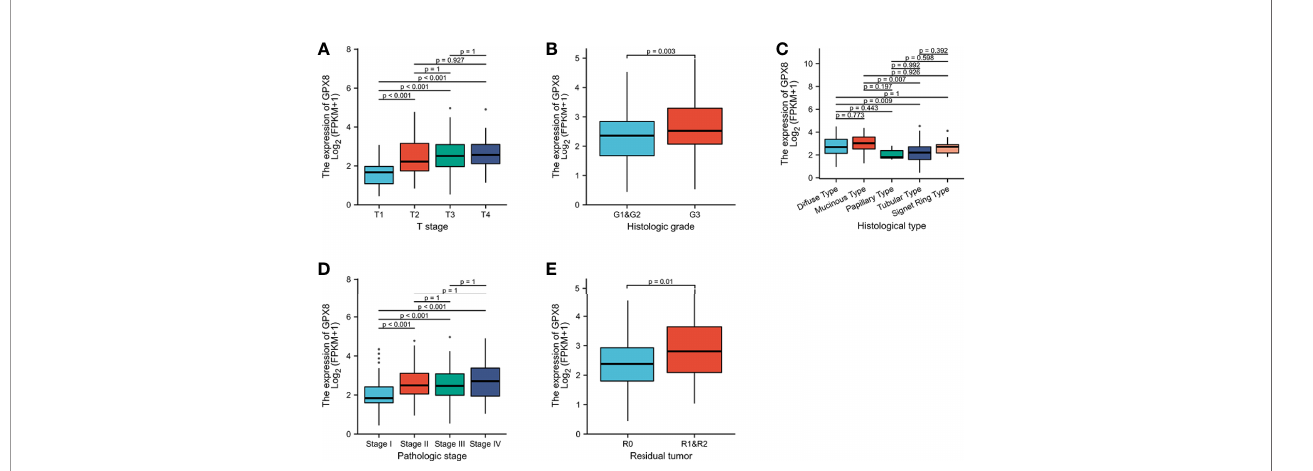
FIGURE 3 | Association between GPX8 expression and clinicopathological characteristics, including (A) T stage, (B) histologic grade, (C) histological type, (D) pathologic stage, and (E) residual